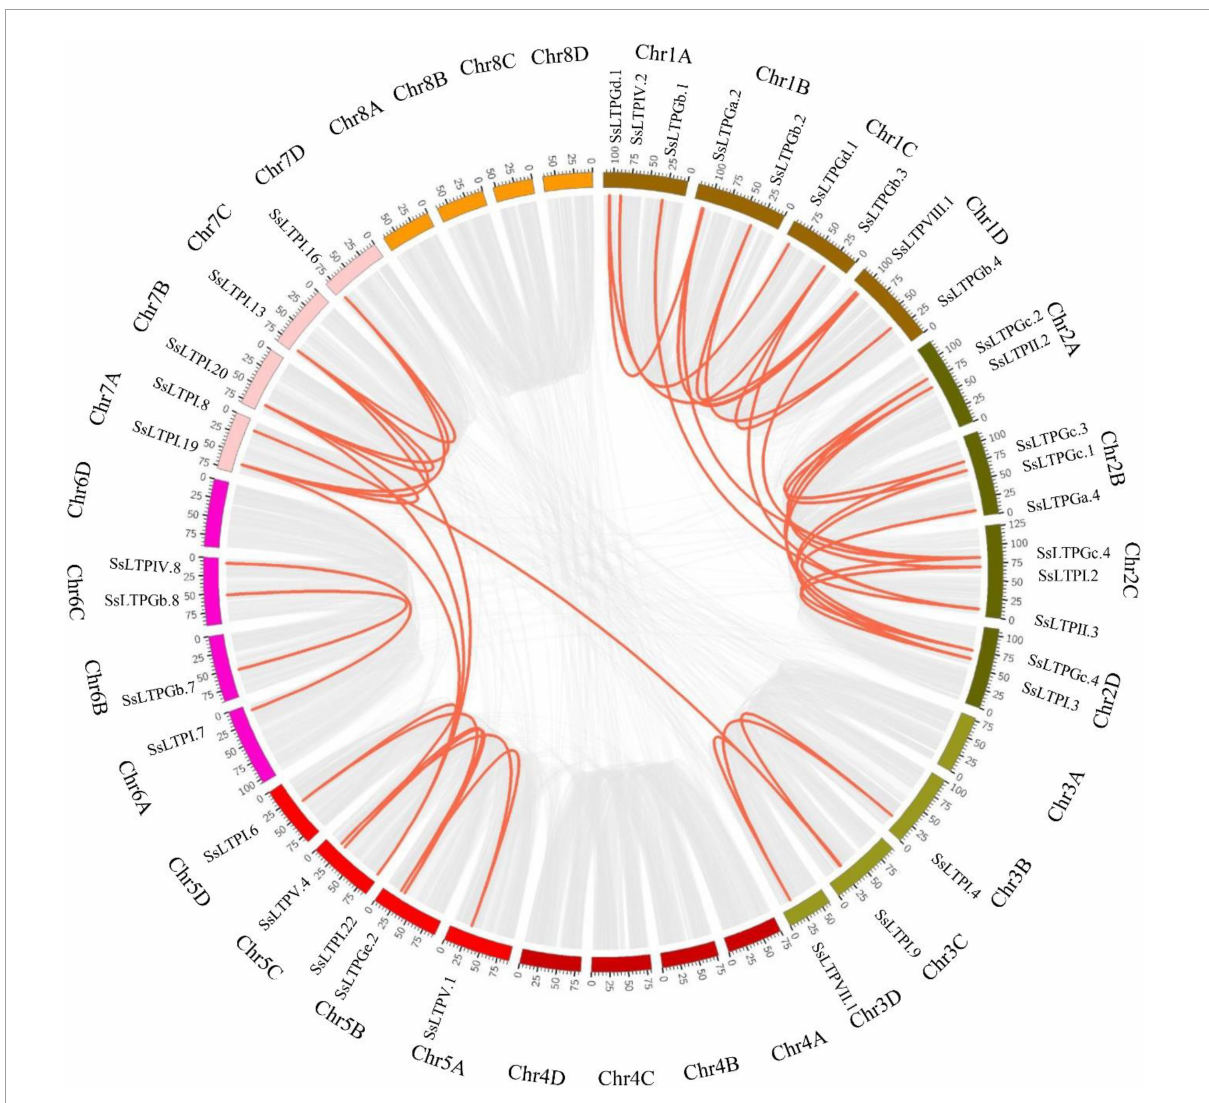
FIGURE4 Gene duplication relationships of SsnsLTP s in the S. spontaneum AP85-441 genome. Gray and red lines represent all genes and SsnsLTP , respectively, that were duplicated in the genome. Chromosome names are displayed in the outermost ring.